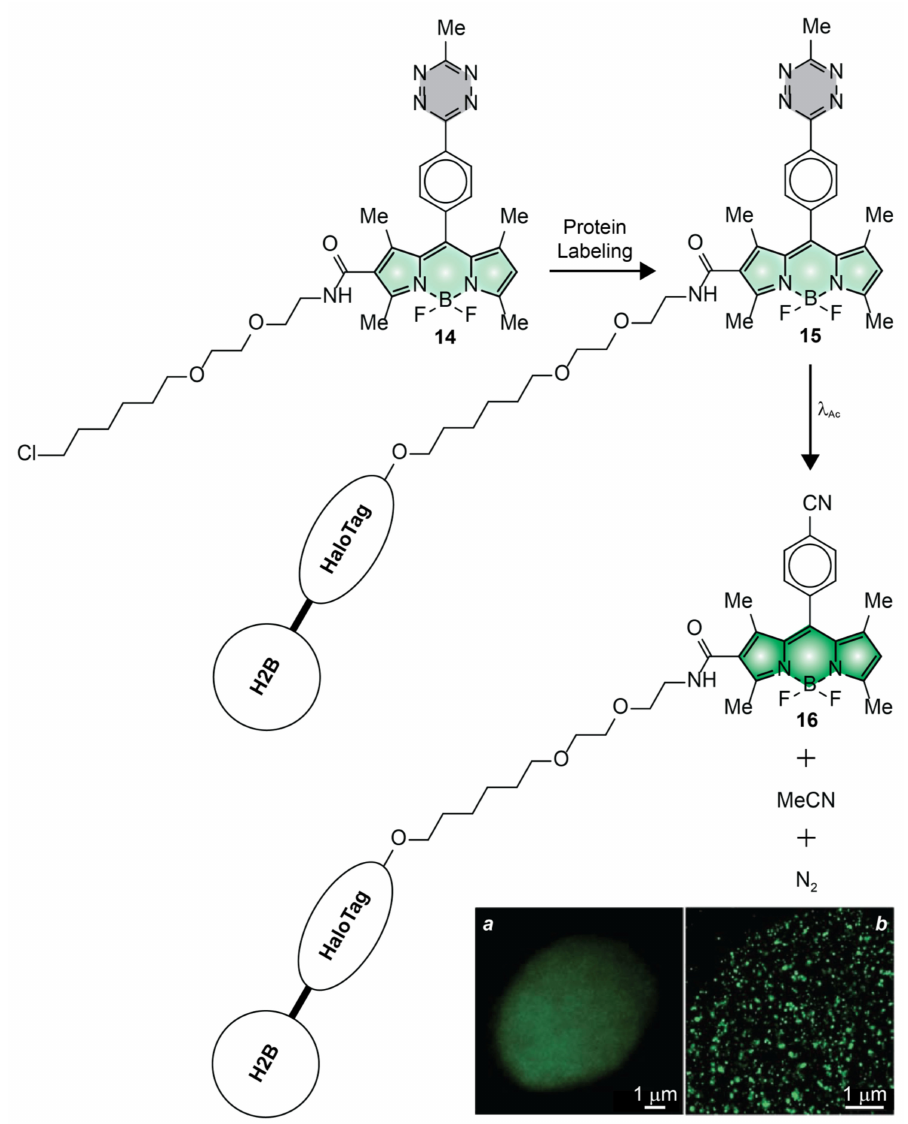
Figure 10. Diffraction-limited ( a ) and PALM ( b ) images of live CHO–K1 cells, expressing H2B–HaloTag labeled with 14 [adapted with permission from Ref.